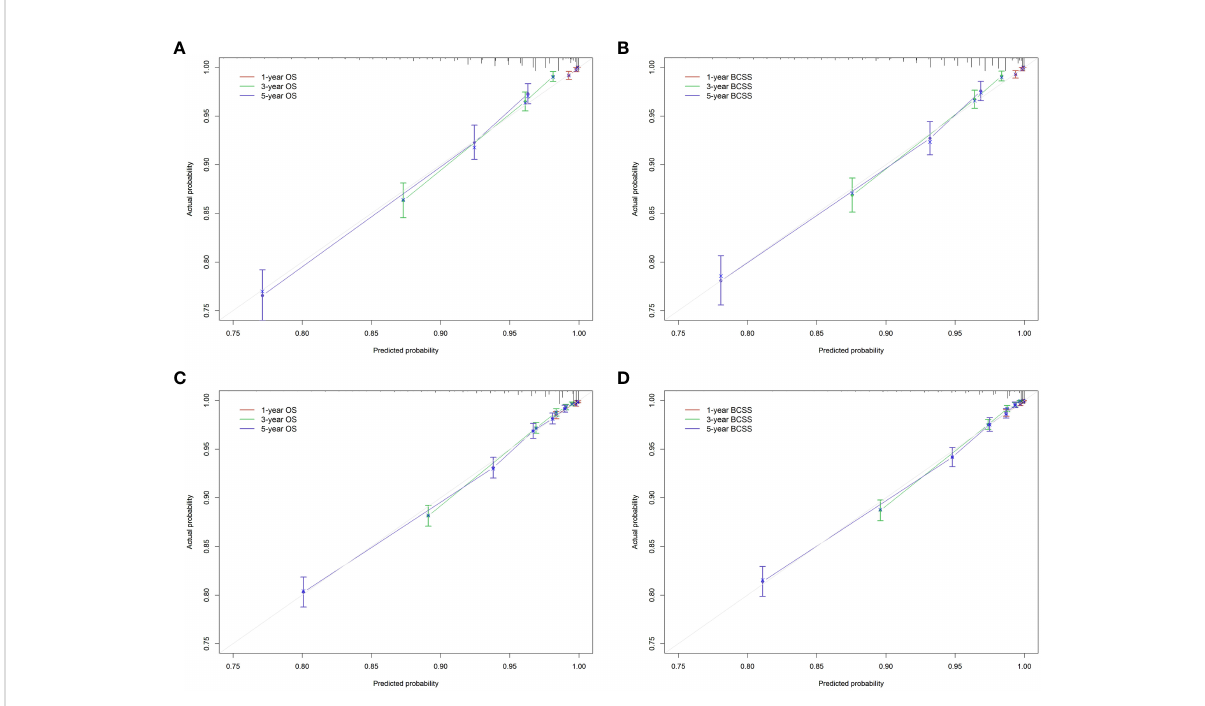
FIGURE 10 Calibration curve of the nomograms. (A) , OS in radiotherapy group. (B) , BCSS in radiotherapy group. (C) , OS in non-radiotherapy group. (D) , BCSS in non-radiotherapy group. OS, overall survival; BCSS, breast cancer-speci fi c